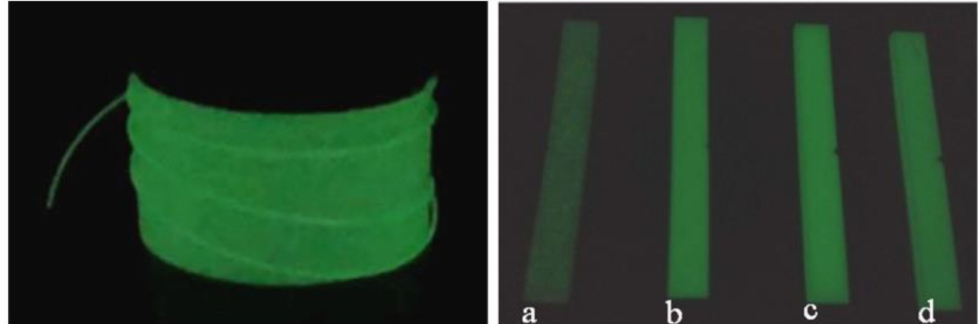
Figure 27. The microscopic image of the composite filament of 1 wt.% modified phosphors and spline with 1 wt.% unmodified phosphors ( a ) and different content modified phosphors ( b – d ) under UV light (b: 1 wt.%, c: 2 wt.%, d: 3 wt.%) scaffold (Reproduced with permission from Reference [188], copyright 2020,